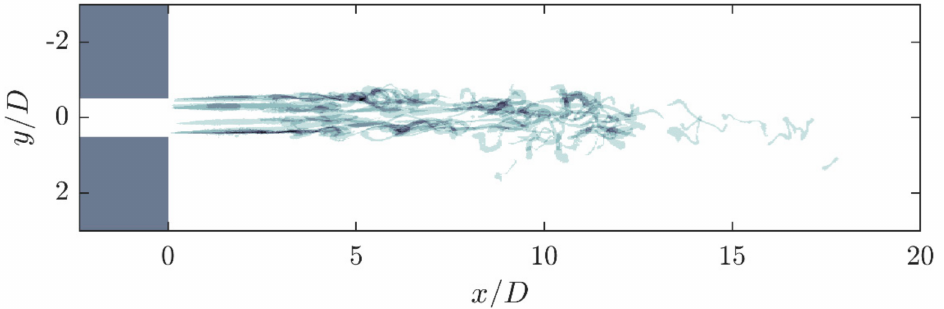
Figure 13. Superposition of the deformed droplet images in original scale at Re = 2000 and λ =